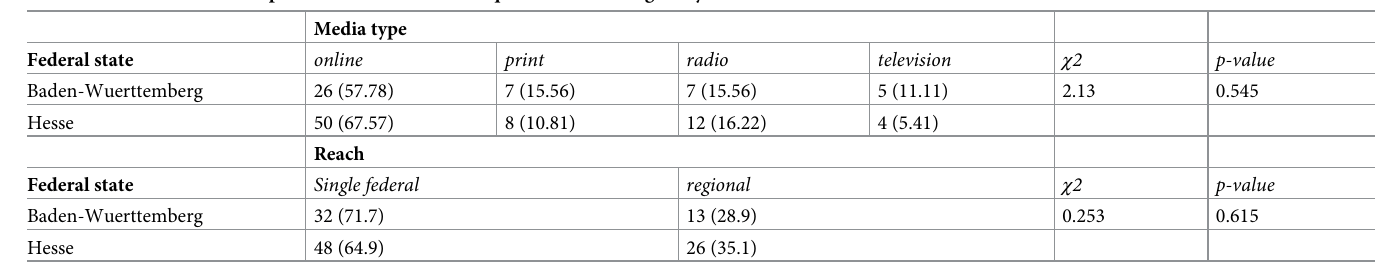
Table 1. Number of media reports and outcome of chi-square test of homogeneity.